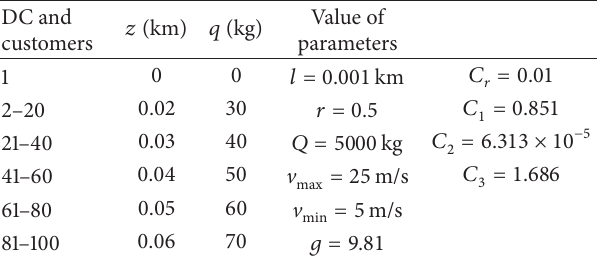
Table 2: The problem instance generated from kroa100. DC